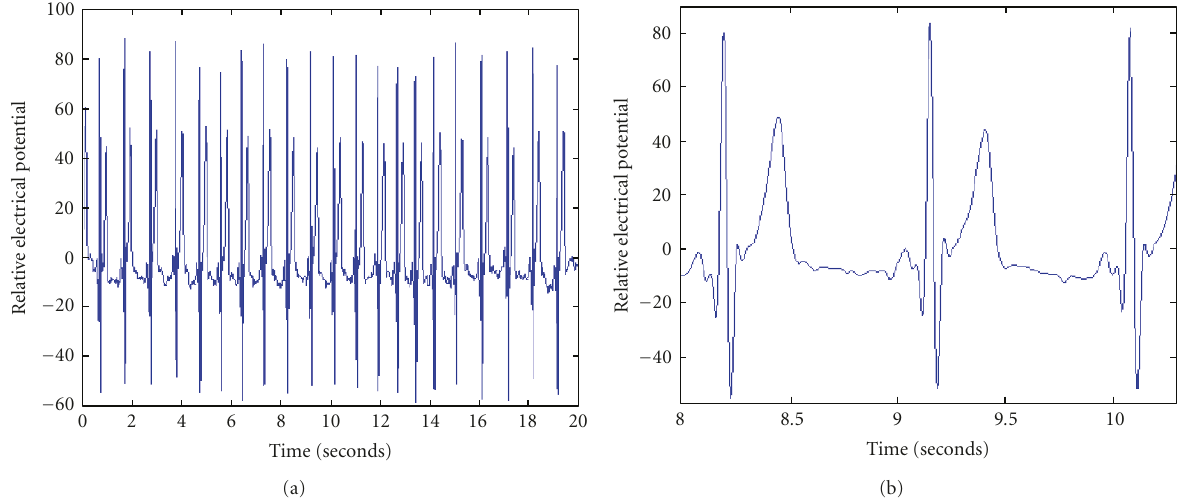
Figure 6: Bandpass filtered ECG trace (a) entire range of data (b) segment of data. The results of applying the filter (Figure 5) to the raw (Figure 4) data are